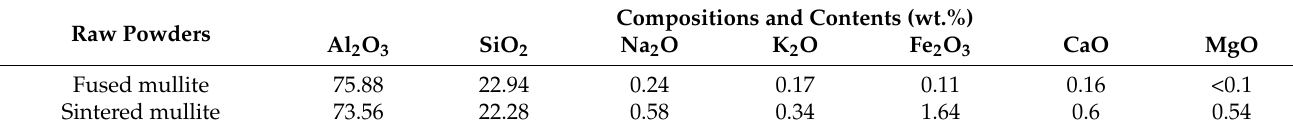
Table 2. Compositions of mullite